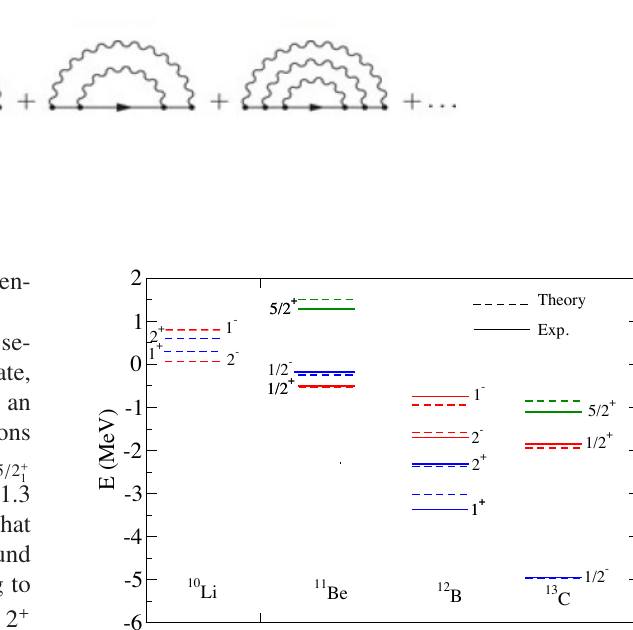
Figure 3. (color online) The experimental energies of the low- lying states in the N = 7 isotones 11 Be, 12 B and 13 C are displayed by solid lines. The corresponding theoretical energies are shown by dashed lines. Also shown are the predictions in 10 Li. States based on 1 / 2 − , 1 / 2 + and 5 / 2 + neutron configurations are shown by blue, red and green lines